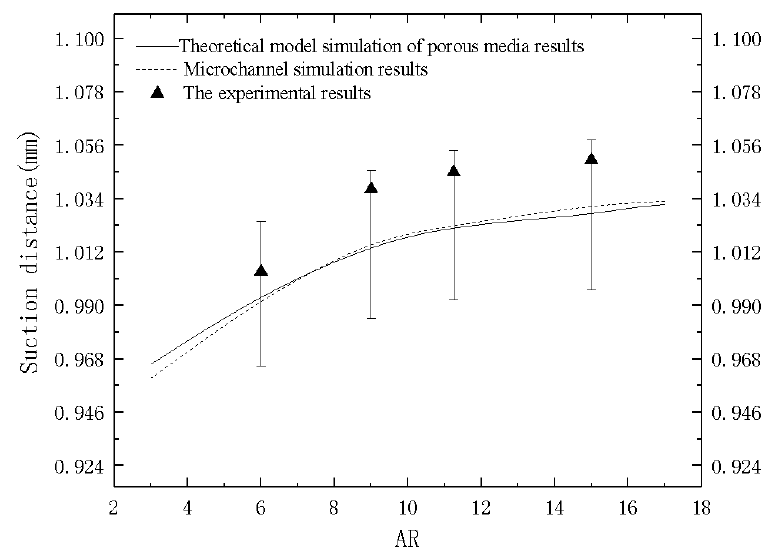
Figure 12. Comparison of experimental and simulation results.